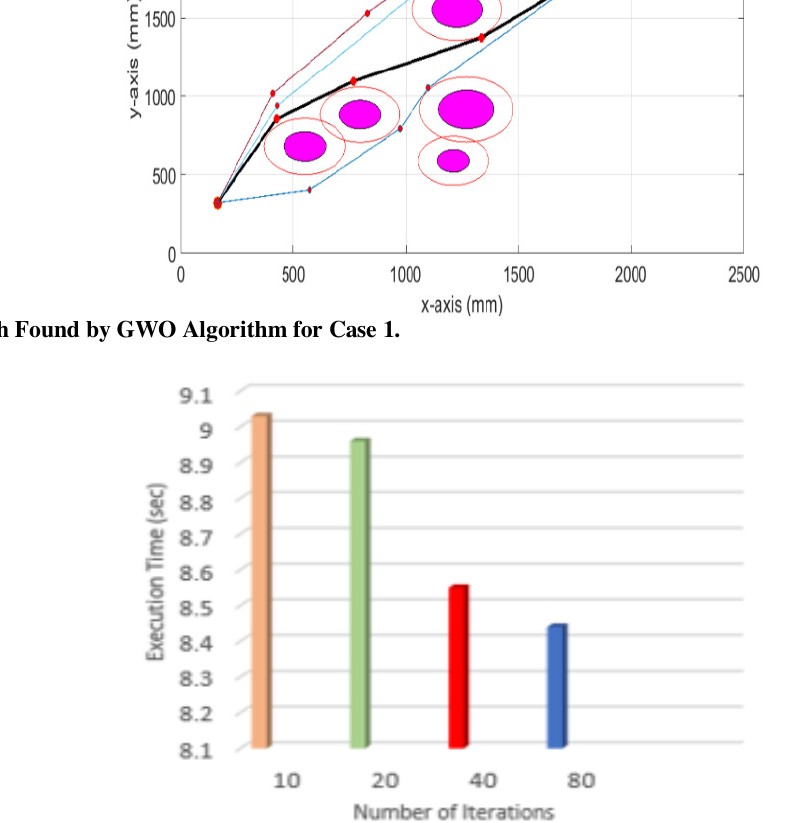
Fig. 13.The execution time of the GWO Algorithm for Case